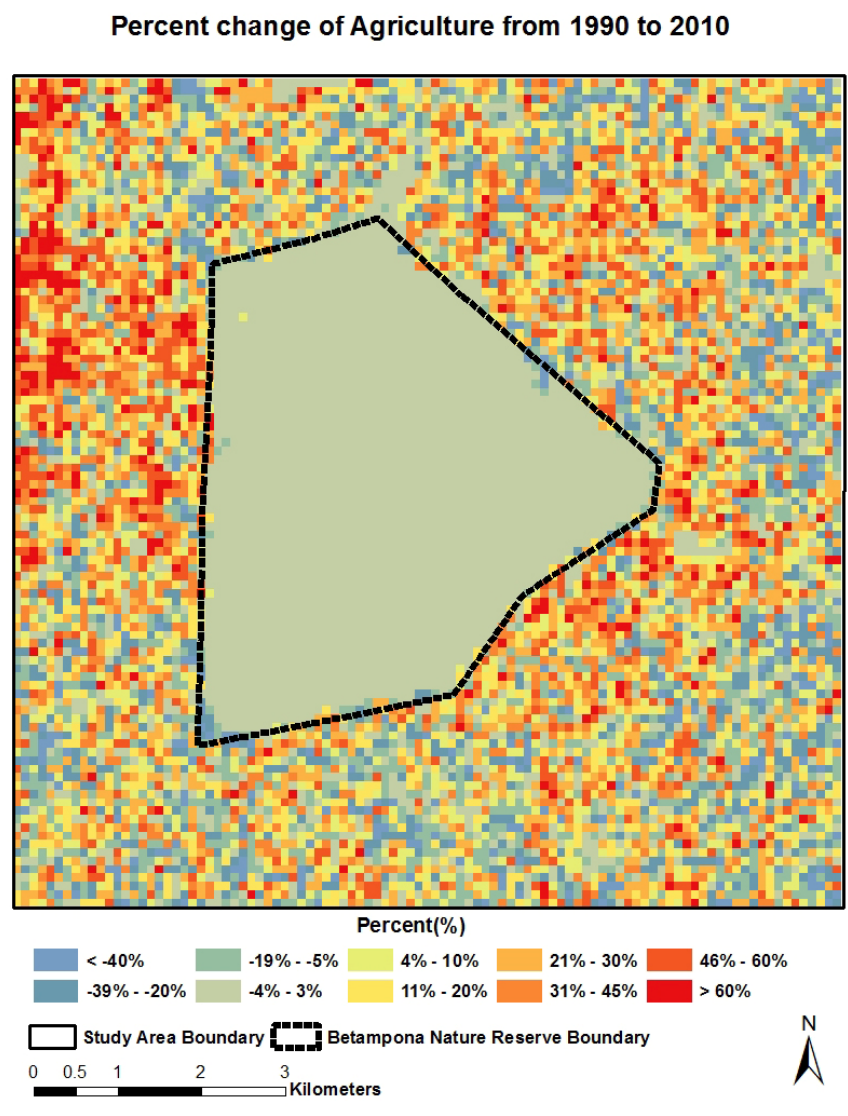
Figure 7. Percentage change of agriculture in each grid cell from 1990 to